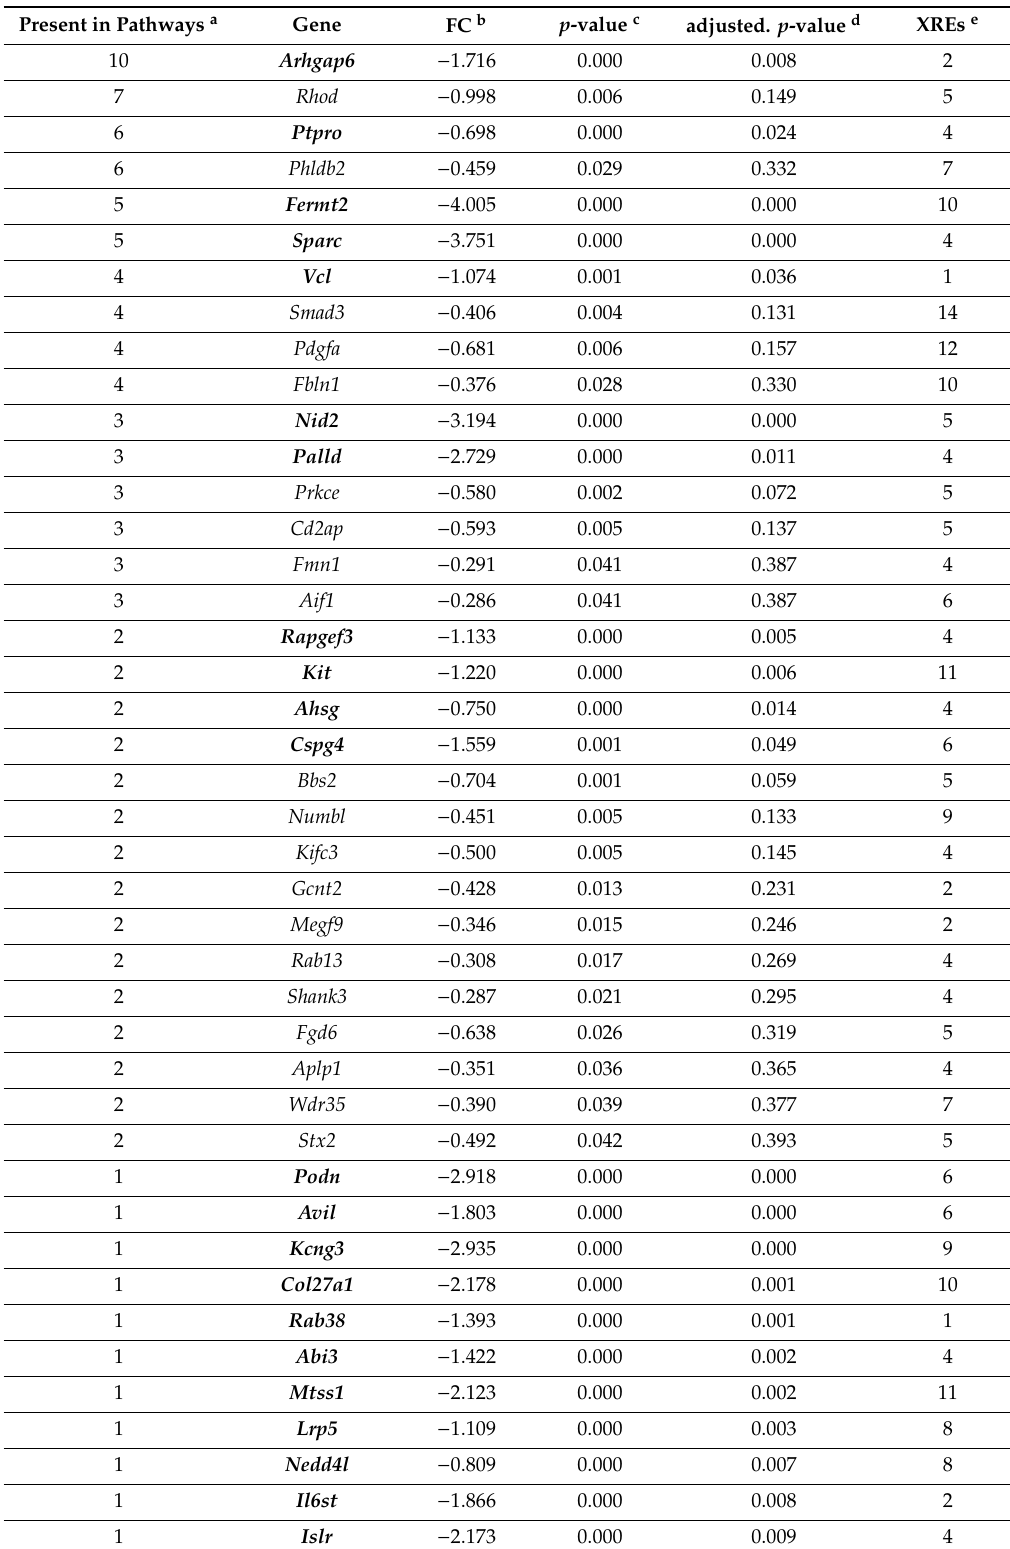
Table 1. Xenobiotic response elements (XRE) sequences in leading-edge genes of negatively associated pathways in DETC from Ahr - / -